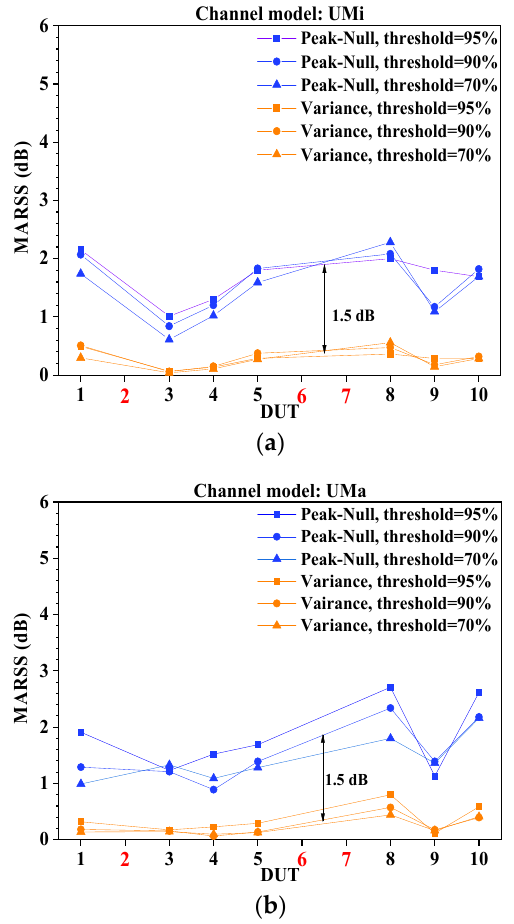
Figure 5. A comparison between Variance and Peak-Null for ( a ) the UMi and ( b ) the UMa channel models for MARSS under CTIA interference-limited environmental condition.